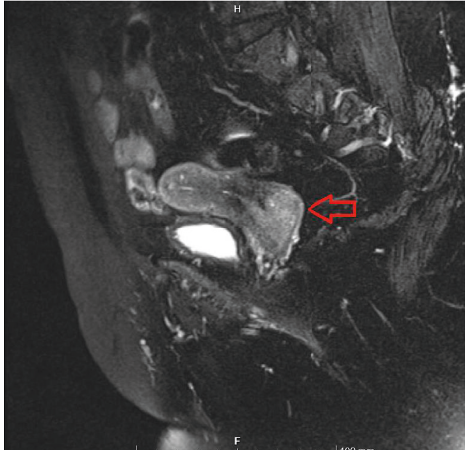
Figure 2: Pelvic MRI showed a lower cervical mass with transmural stromal involvement measuring 4 × 4 × 3 cm (arrow). It is pro- truding to the upper half of the vagina and expanding vaginal